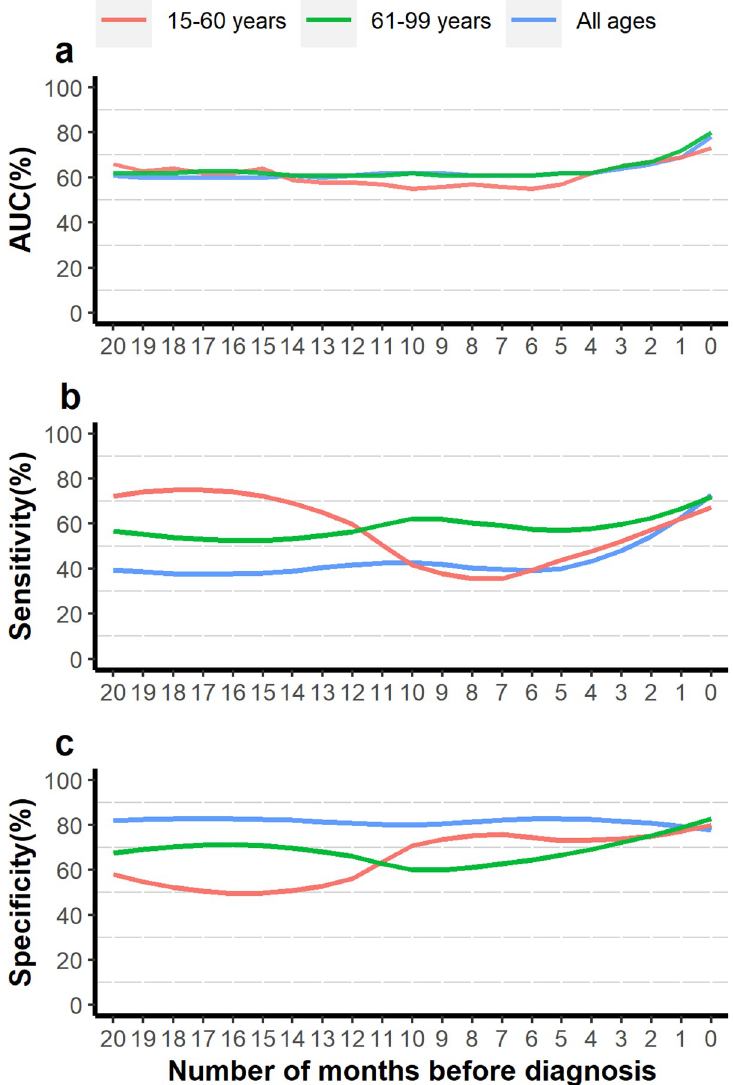
Fig 2. Model parameters obtained in each time window (0–24,1–24, ... ,20–24 months) prior to diagnosis. a) AUC (%) b) Sensitivity (%) c) Specificity (%).